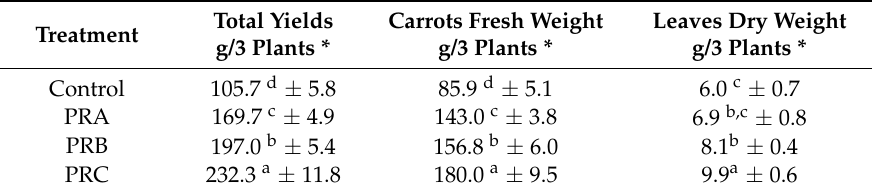
Figure 10. The P, K, and N uptake content ( a ) and available P in soils ( b ) of samples that underwent different treatments [reported values are statistically significant (p < 0.05)].